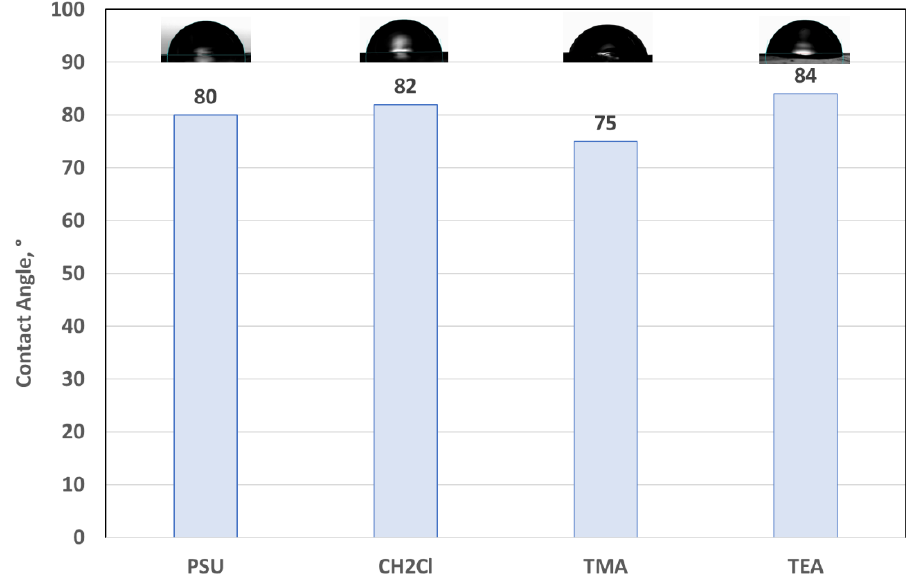
Figure 5. Contact angle of 60% DF samples as a function of different functionalization reaction steps. The drop used for the contact angle calculation is reported above each sample.